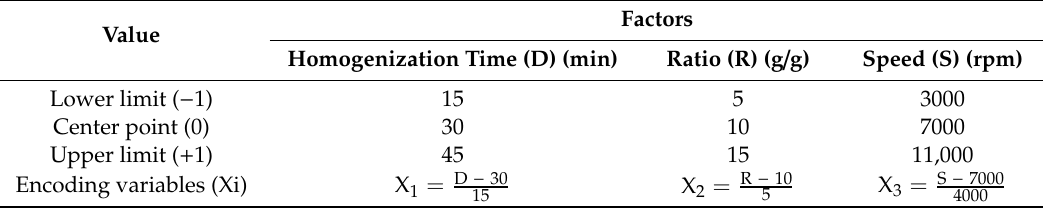
Table 1. Examined parameters for response surface methodology (RSM) optimization and their bound values. Factors Value Homogenization Time (D) (min) Ratio (R) (g / g) Speed (S) (rpm) Lower limit ( − 1) 15 5 3000 Center point (0) 30 10 7000 Upper limit ( + 1) 45 15 11,000 Encoding variables (Xi) X 1 = D − 30